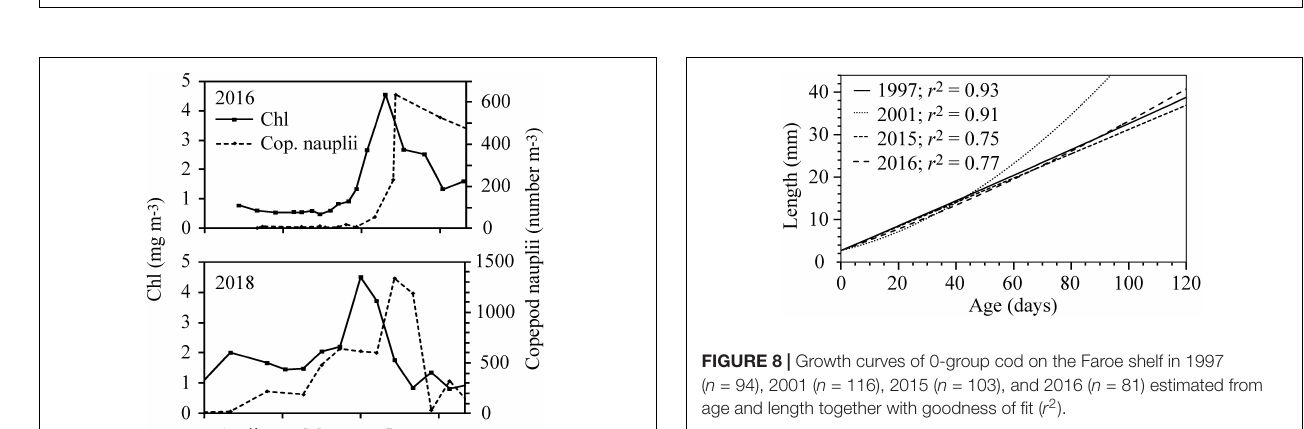
FIGURE 6 | Chl at station S from April to July 1997–2018. The gray bars indicate the timing of the 0-group survey. Years enclosed in a box are years where subsamples of cod were age analyzed.